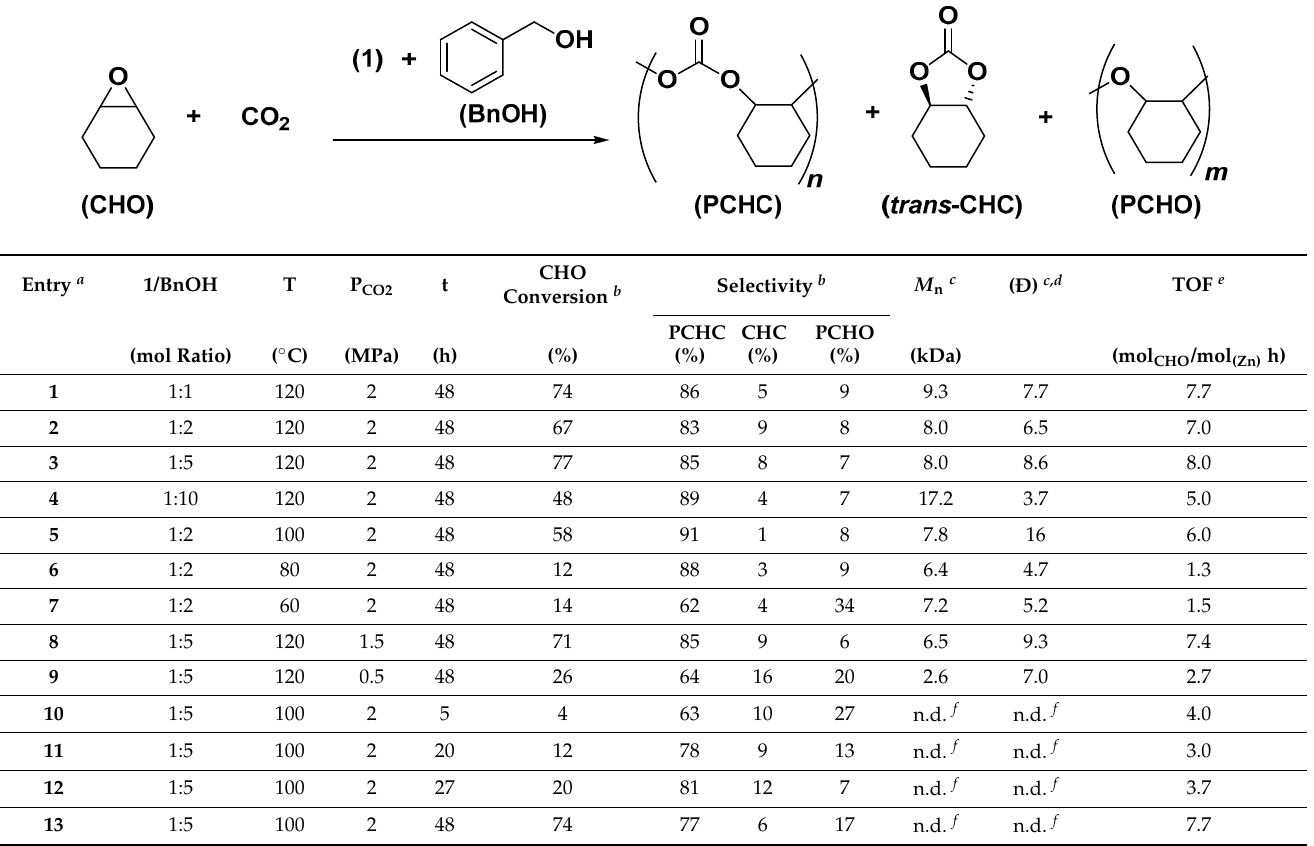
Table 2. ROCOP of CHO with CO 2 promoted by complex 1 using BnOH as initiator.